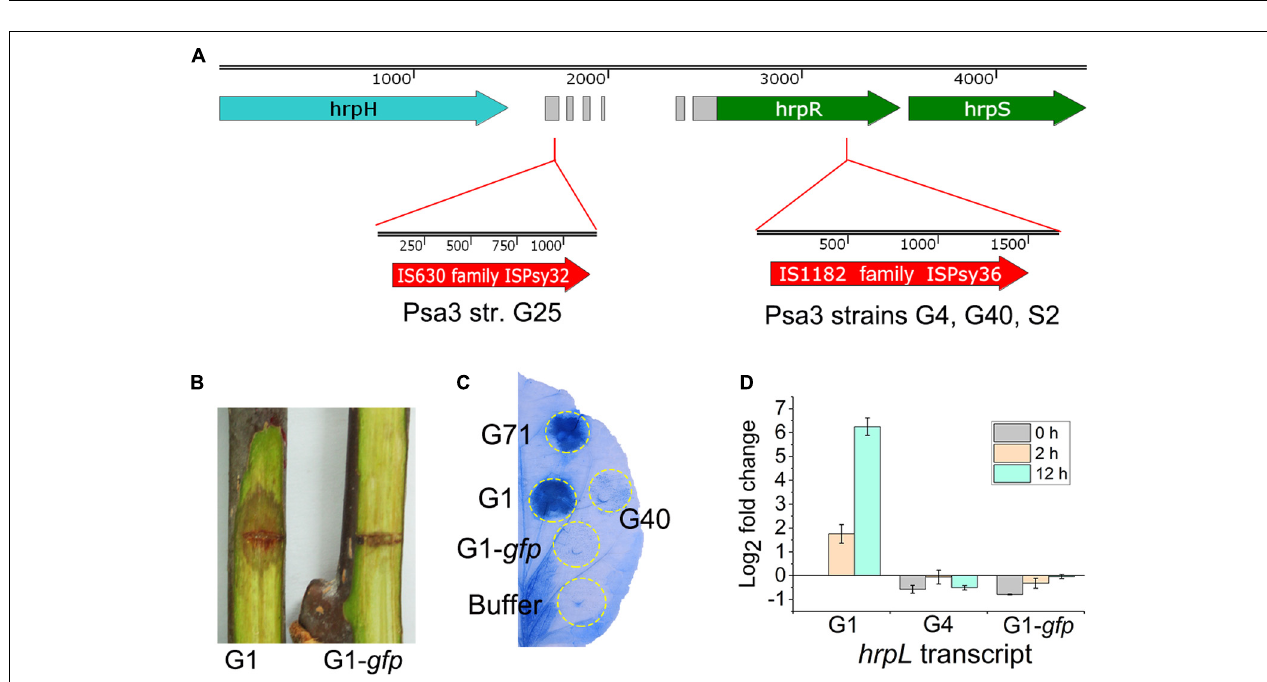
FIGURE 5 | Genetic causes of the phenotypically-changed isolates within Pseudomonas syringae pv. actinidiae biovar 3 (Psa3). (A) ISPsy32 and ISPsy36 were inserted in the conserved region upstream and inside the hrpR gene, resulting in the low-virulent and non-pathogenic Psa3 isolates, respectively. The gray modules between the hrpH and hrpR genes represent the conserved sequences among diverse P. syringae pathovars. (B,C) An artificial mutant G1- gfp exhibited no pathogenicity on kiwifruit canes, and lost the ability to elicit a hypersensitivity response (HR) in non-host Nicotiana benthamina leaves. G1- gfp was constructed by an 841-bp gfp fragment insertion in the same location (as the ISPsy36 insertion in G25) of the hrpR gene in the high-virulent isolate G1. The N. benthamina leaves were infiltrated with bacterial suspensions (10 8 CFU/mL) and photographed at 36-hour post infiltration. (D) The qRT-PCR results indicated that transcriptional patterns of the hrpL gene in G4 and G1- gfp were similar in the hrp -derepressing medium (HDM), while different from that of G1. Two house-keeping genes gyrA and gyrB , which constitutively expressed in bacteria, were used as the internal control. The experiments were repeated three times with similar